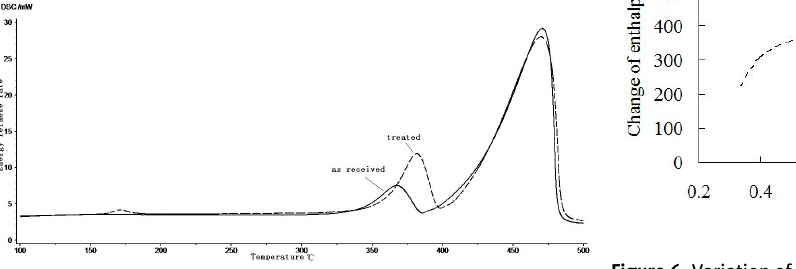
cle for a thermal storage using the reaction Ca(OH) 2 → CaO +H 2 O per mole [13]. The decomposition of Ca(OH) 2 into CaO+H 2 O requires an energy input of 148.6 kJ (=54.0 heat- ing + 94.6 decomposition) to decompose 1 mol of Ca(OH) 2 at 25 ∘ into CaO+H 2 O at 510 ∘ [13]. The produced CaO can be stored easily as a solid at 25 ∘ , after losing 23.5 kJ.